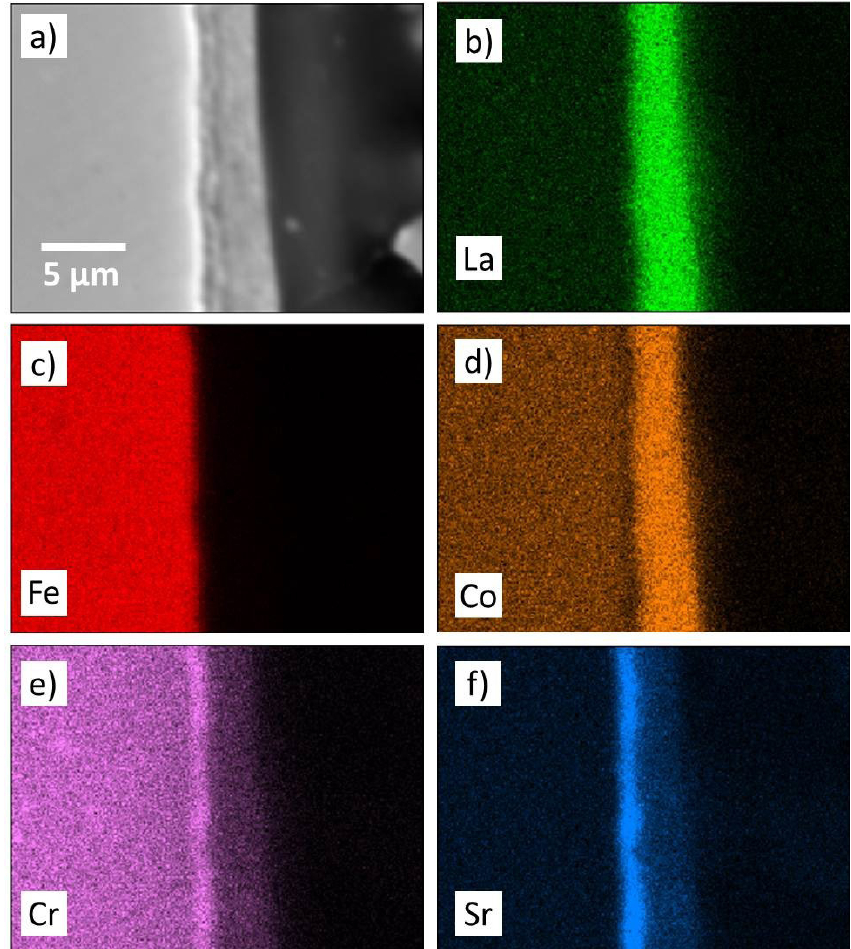
Figure 3. Elemental distribution of the cross-section of LSC coated substrate: (a) SEM-SE image (b) La (c) Fe (d) Co (e) Cr (f) Sr.